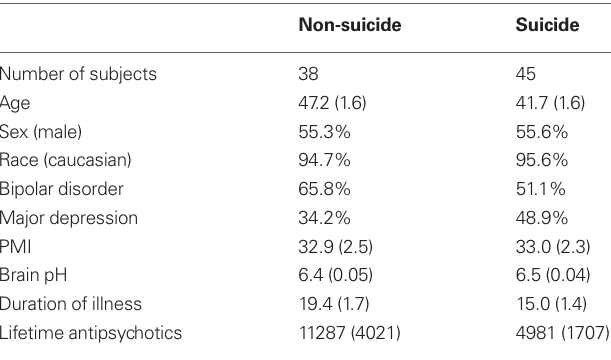
Table 1 | A summary of subject characteristics included in suicide microarray